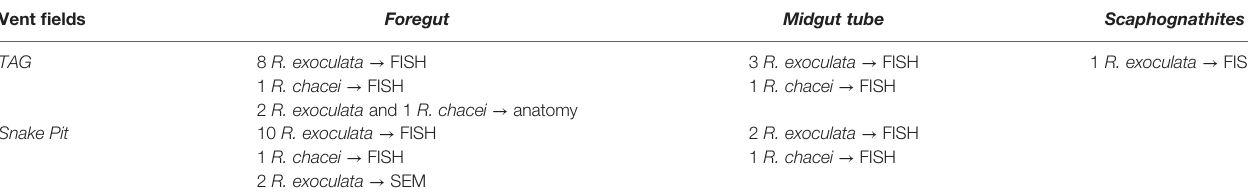
TABLE 1 | Samples selected for the different approaches: SEM, FISH and dissection under binocular microscope. Vent fi elds Foregut Midgut